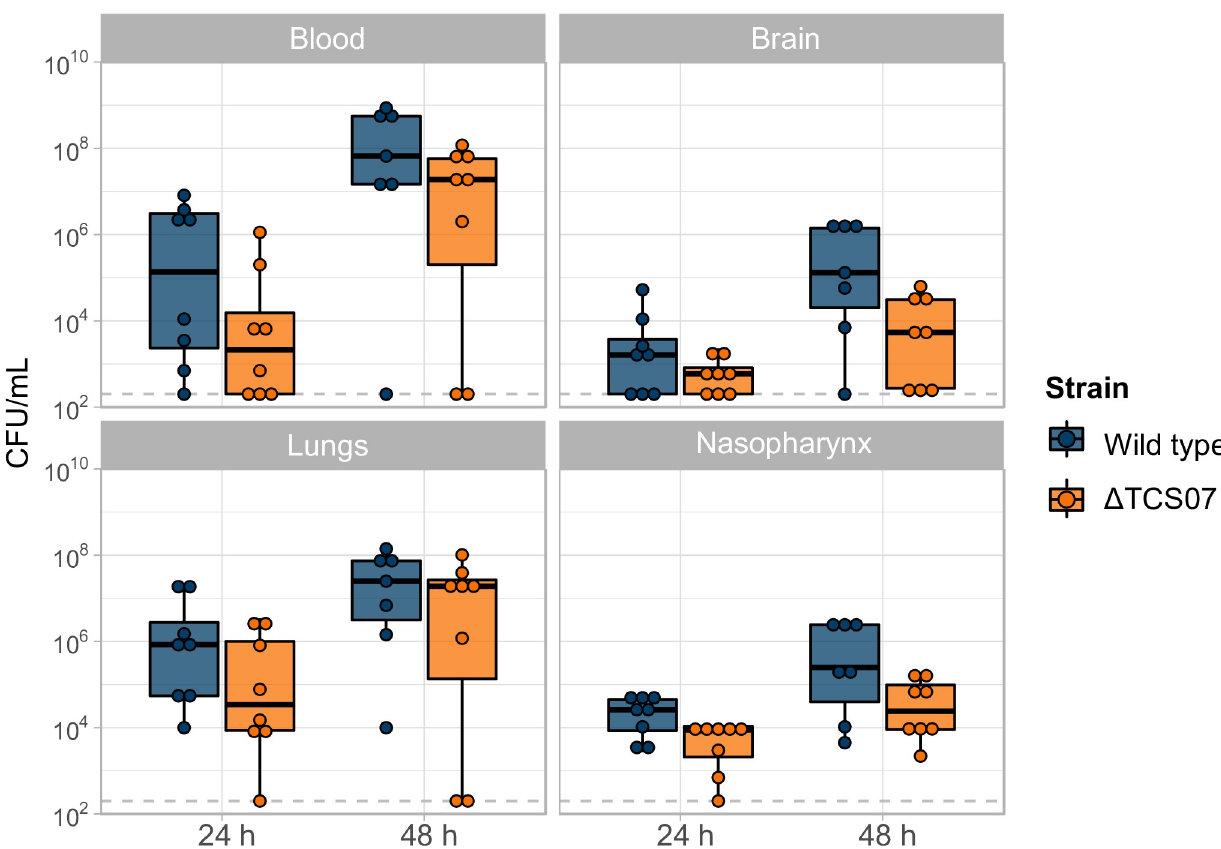
Fig 6. TCS07 increase virulence in a mouse infection model. 5 weeks old anesthetized female Swiss mice were challenged intranasally with 10 7 CFU of wild type D39 or Δ TCS07. After 24 or 48 h mice were euthanised, blood and tissues were harvested and CFU was determined by serial dilution and plating. One mouse in the 48 h wild type group died from the infection. Statistical analysis was performed with a linear mixed effect model, (details in materials and methods). Deletion of TCS07 significantly reduced virulence (p-value = 0.02916, χ 2 (1) = 4.7579), and on average reduced bacterial loads 9.24-fold ± 2.67 (standard